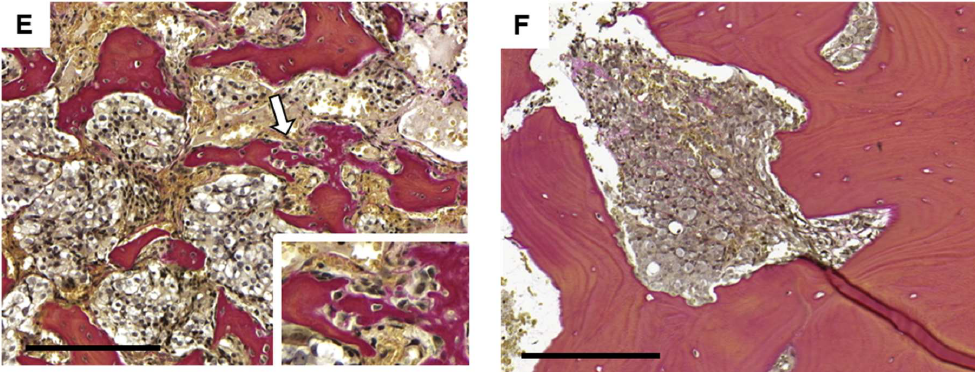
Figure 3. Representative immunostaining of runt-related transcription factor 2 ( A , B ), tartrate-resistant acid phosphatase ( C , D ) and van Gieson ( E , F ) in metastatic lesions with high ( A , C , E ) and low (B , D , F ) bone cell activity. The area with newly formed bone is indicated with an arrow and magnified ( E ). Bar indicates 200 µm.